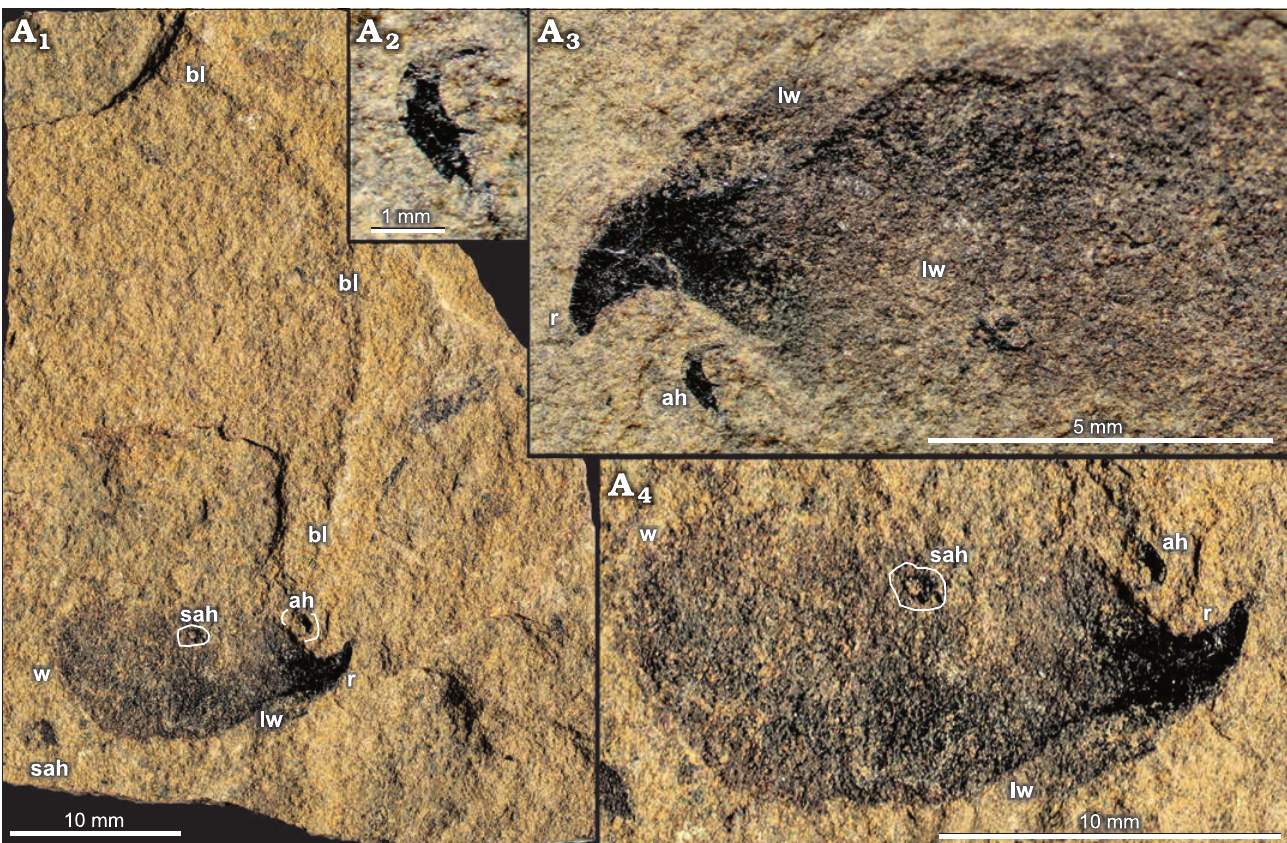
Fig. 5. The isolated upper beak and arm hooks of unknown coleoid (GM-P393) from the Buchenstein Formation, uppermost Anisian, Middle Triassic, Seceda Mountain, Gardena Valley, NE Italy. A 1 , an overview of the specimen; A 2 , enlarged arm hook; A 3 , the anterior part of the upper beak showing a pointed hook-shape rostrum and a deep U-shape inter-space between the lateral walls; A 4 , S-shape boundary between a rostrum and lateral wall. Abbreviations: ah, arm hook; bl, the curved broken lines consisted from the hook-like structures in the vicinity of the isolated upper beak from the NE Italy; lw, lateral wall of the upper beak; r, rostrum of the upper (dorsal) beak; sah, transversely sectioned arm hook; w, wing of the beak.